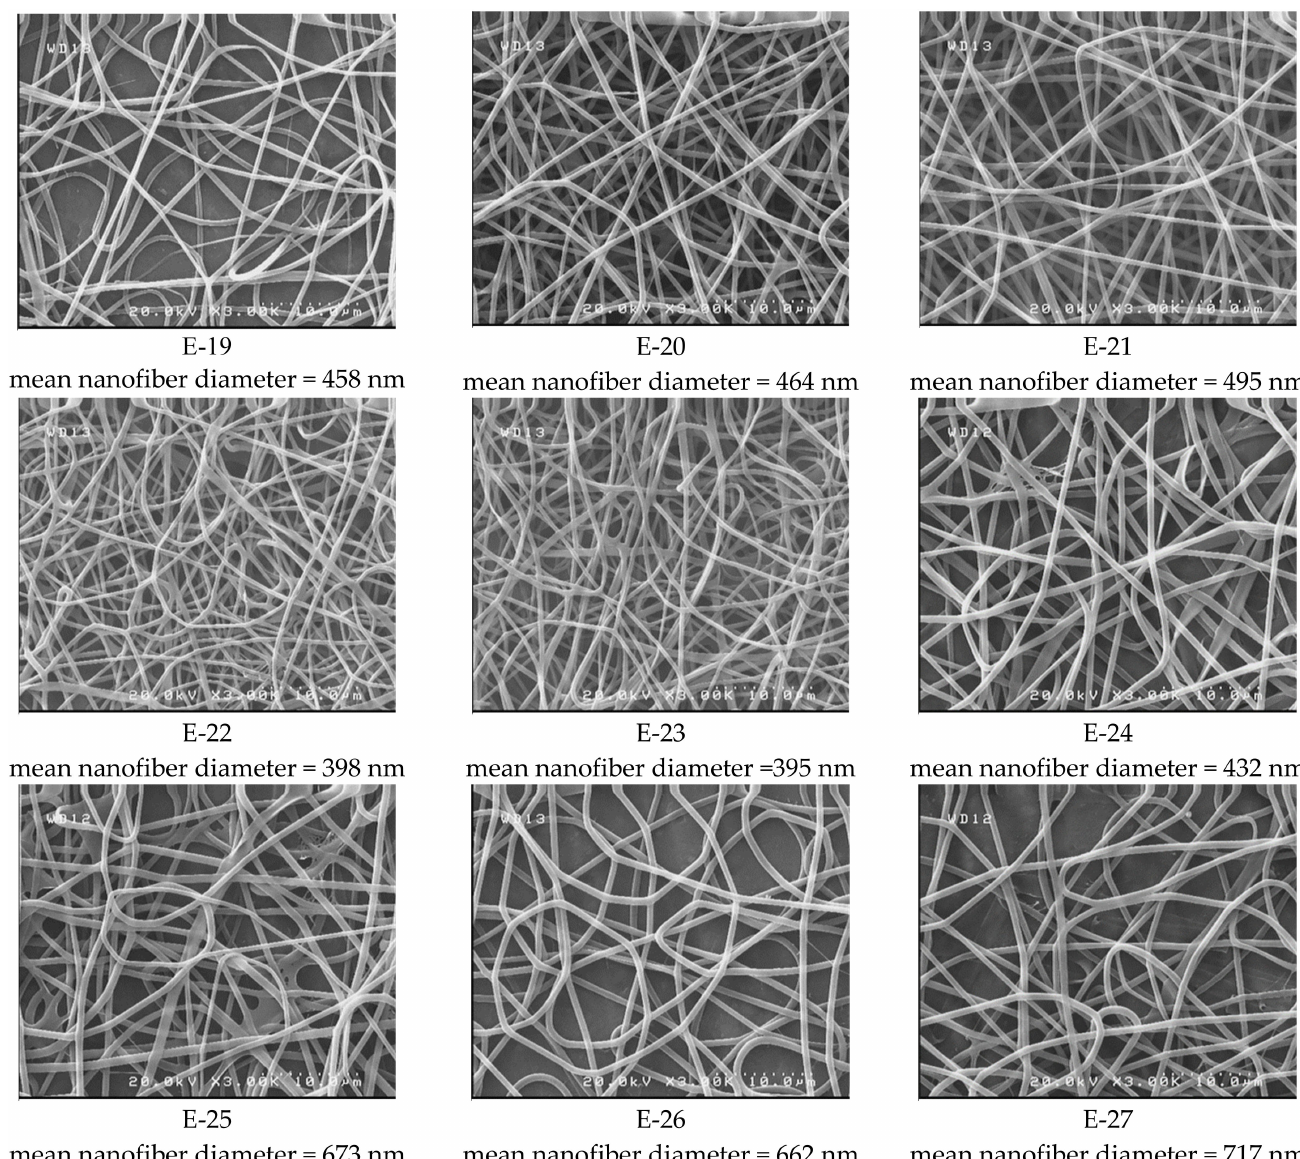
Figure 4. FEEM images of PVOH nanofibers related to experiments 19–27 of the Taguchi method. The diameter of the electrospun polymer nanofibers was found to decrease with increasing applied voltage. When a voltage higher than the critical voltage is applied, charged jets are ejected from the Taylor cone. In fact, when an electric field is applied to a droplet of polymer solution at the tip of needle, the surface of the droplet becomes charged and the electric force overcomes the surface tension force; as a result, the electrically charged jet is formed. A higher voltage increases the electrostatic repulsion force on the charged jet, resulting in a decrease in the diameter of the electrospun polymer nanofibers [44]. The results also show that the concentration of polymer solution in the electrospinning process plays an important role in determining the polymer nanofiber diameter. The diameter decreases as the concentration decreases. This can be attributed to the fact that when the polymer content in the electrospinning solution (concentration of polymer chains) decreases, the viscosity of the solution decreases, resulting in less entanglement of the polymer chains in the solution, which leads to the formation of nanofibers with a smaller diameter [45]. It can also be seen in Figure 5 that decreasing the distance between the electrodes causes the diameter of nanofibers to decrease. The difference in collection distance (distance